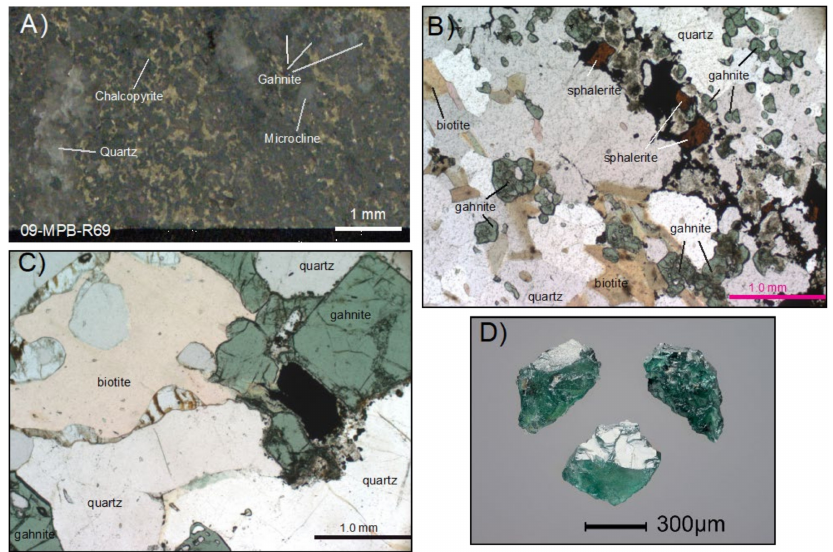
Figure 7. Gahnite grains in bedrock and till samples from Izok Lake: ( A ) polished slab of drill core (sample 09-MPB-R69); ( B , C ) polished thin sections (sample 09-MPB-R37 and 09-MPB-R41B, respectively); ( D ) grains from heavy mineral concentrate of till sample 12-MPB-913 (photograph by M.J. Bainbridge Photography). Modified from Hicken (2012)